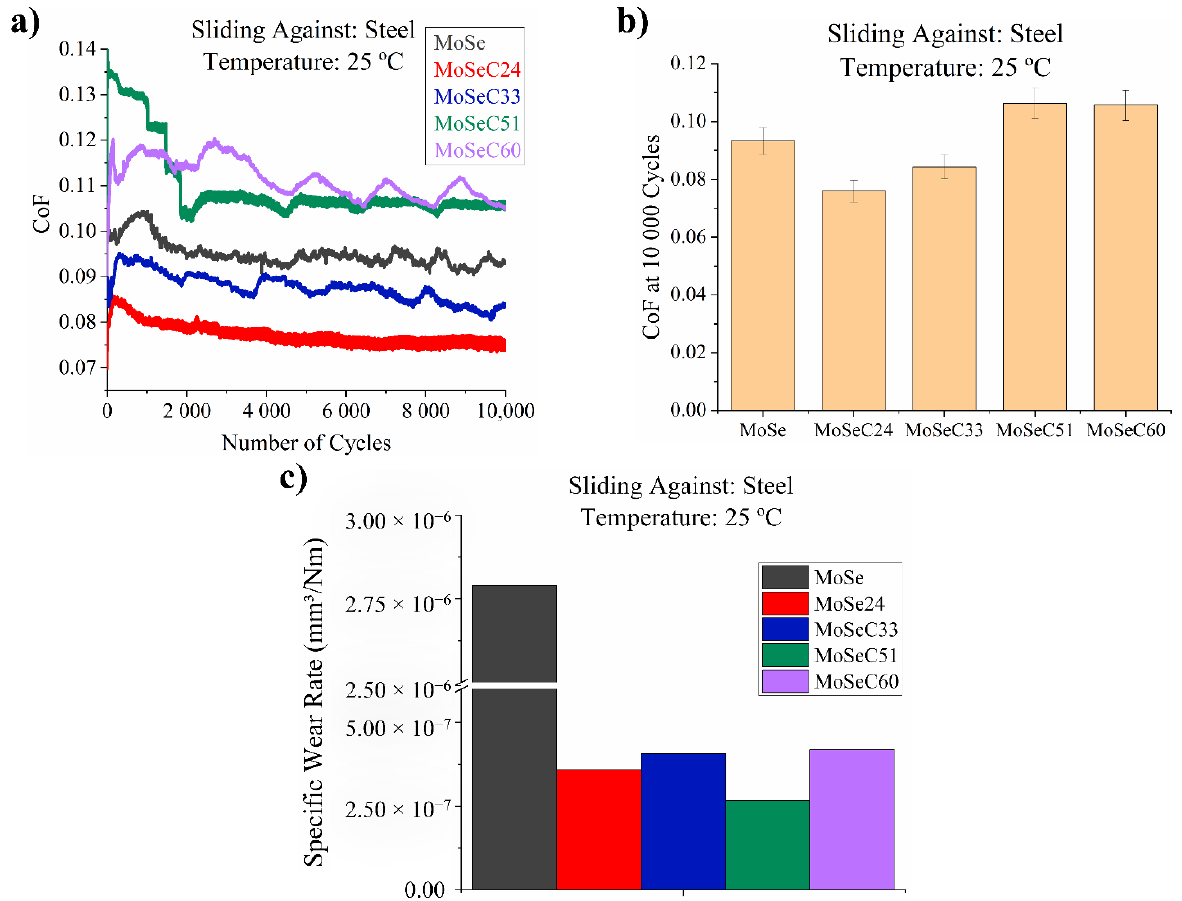
Figure 7. Results of the POD tests for coatings, performed against a steel countersurface, at 25 °C: ( a ) friction curves; ( b ) final coefficient of friction (CoF); ( c ) specific wear rates obtained via 3D optical profilometer.